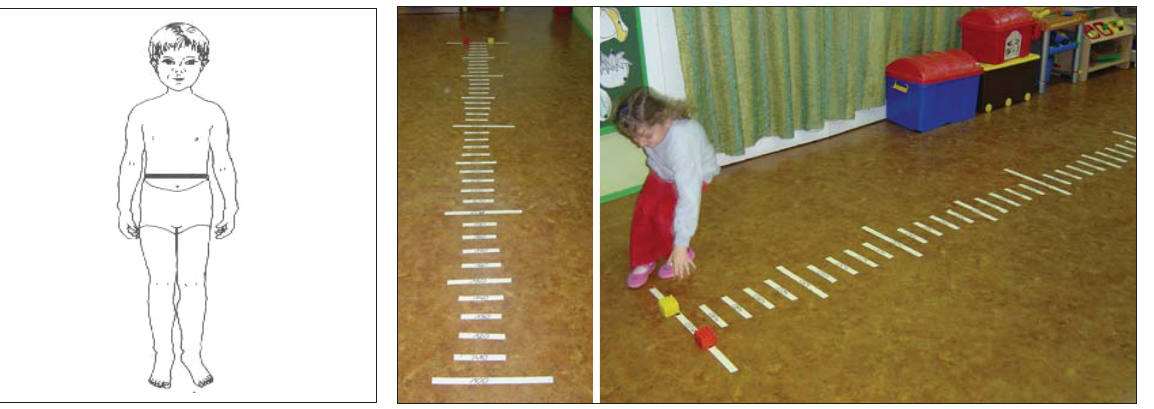
Figure 1. Tape position for measuring waist circumference (Moreno et al., 1999; McCarthy et al., 2001; Freedman et al., 2004)